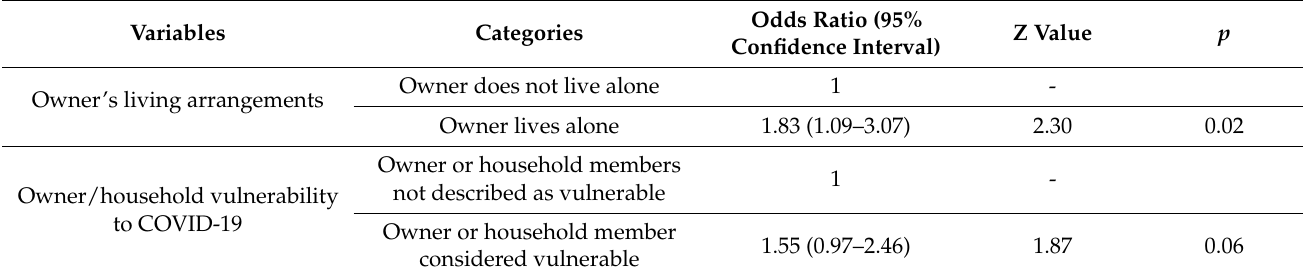
Table 5. Multivariable logistic regression model for reduction in person’s total weekly dog walking duration during the COVID-19 lockdown. Model based on 489 observations, X 2 = 7.67, p = 0.02, AIC = 572.63.